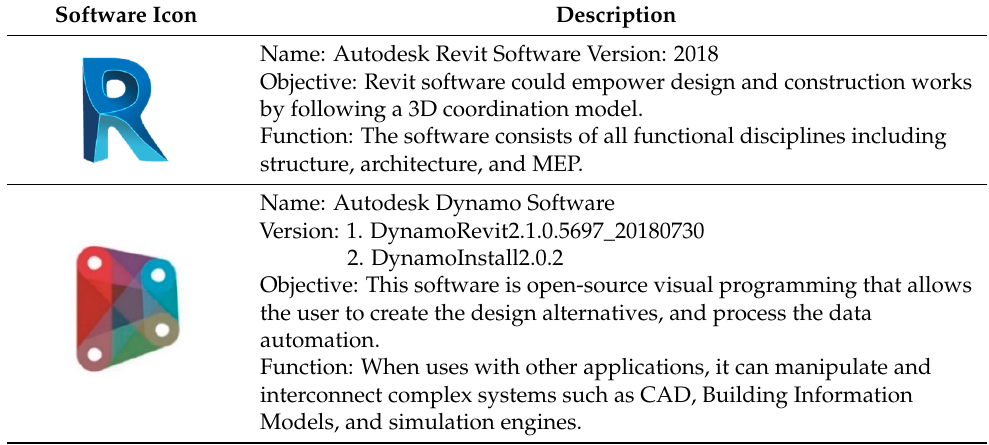
Figure 13. Three options of kingpost relocation.